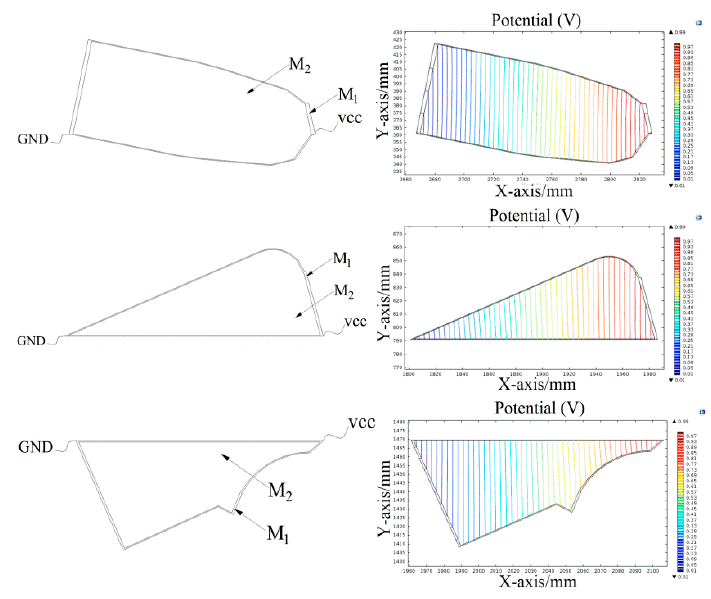
Figure 11. The simulation of constant current field of the conductive plane.